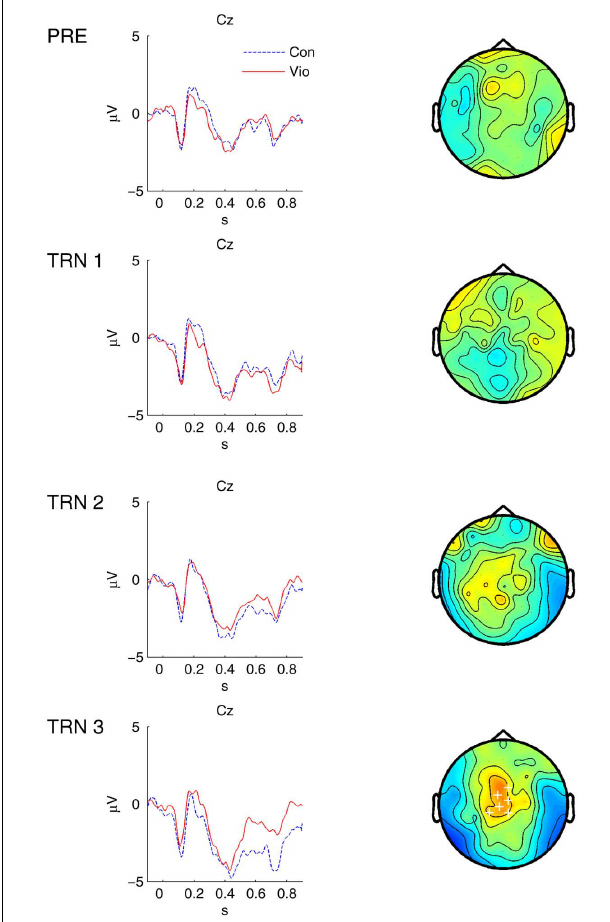
Table 3 | Statistics for violation-related EEG